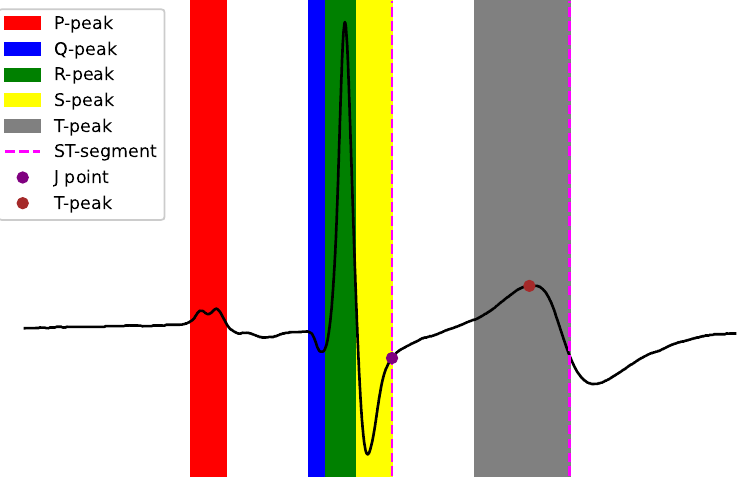
Figure 1. ECG beat morphology example. Note the vertical dotted lines representing the ST-segment, which is the interval between ventricular depolarization (shift in electric charge distribution inside the cell) and repolarization (J-point elevation)